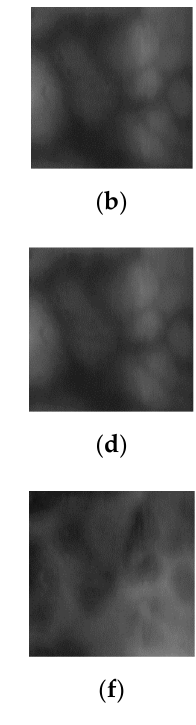
Figure 7. Difference images of registered and input images. ( a ) Registered image, ( b ) input image of same class as registered image, ( c ) difference image of ( a , b ), ( d ) registered image, ( e ) input image of different class as registered image, and ( f ) difference image of ( d , e ).